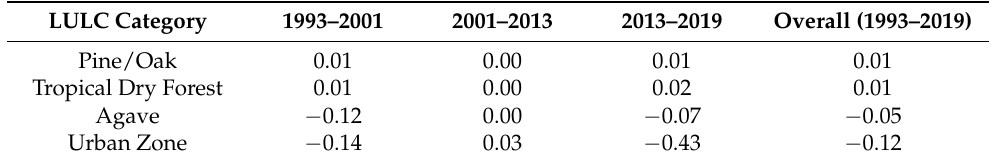
Table 6. LULC change